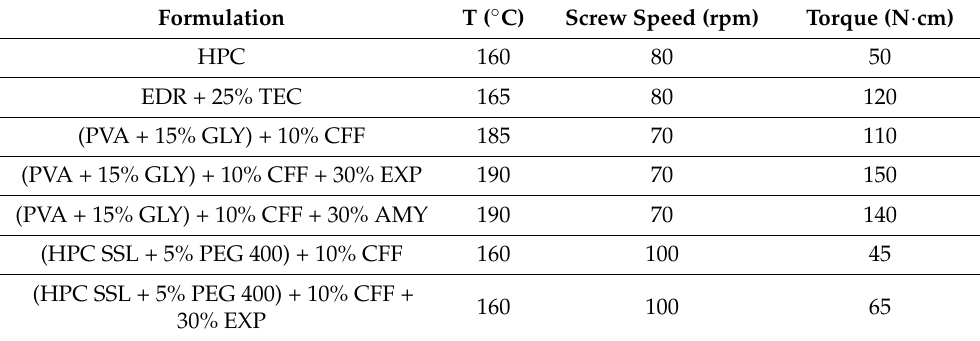
Table 1. Formulation of filaments and extrusion